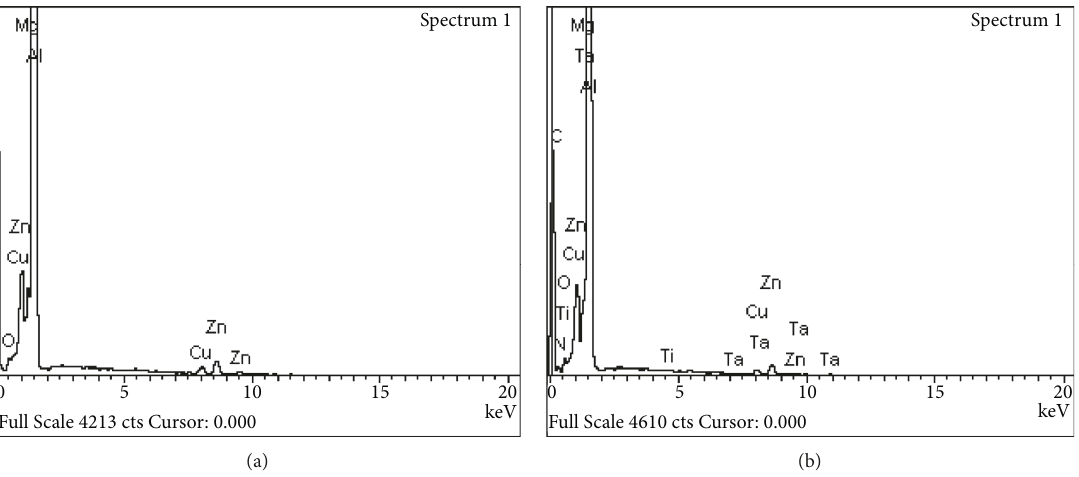
Figure 10: EDAX pattern of (a) AA7075 and (b) AA7075+1wt%TaC+8wt%Si